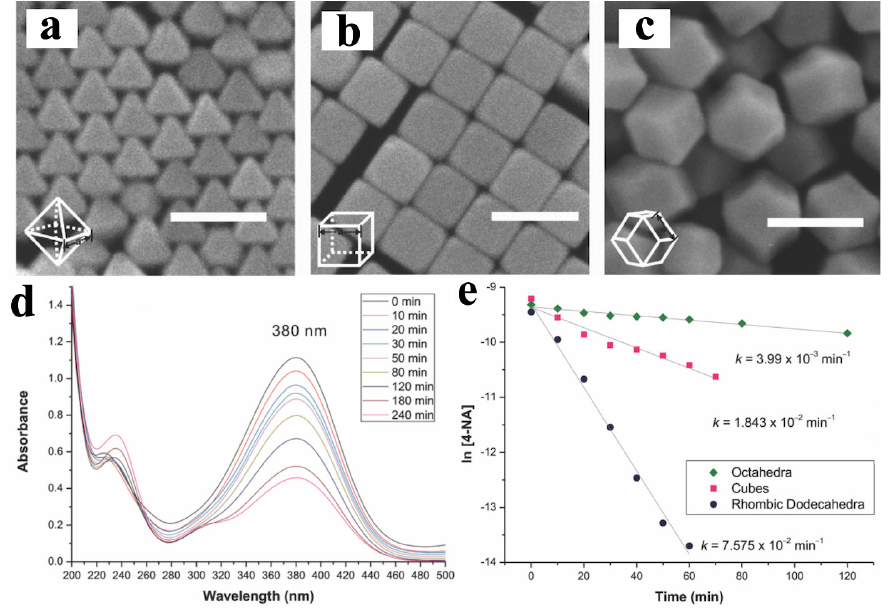
Figure 13 - SEM images of a) Au octahedra, b) Au nanocubes, and c) Au rhombic dodecahedra. Scale bars are equal to 100 nm. d) Time-dependent UV-vis absorption spectra for the borohydride reduction of 4-aminophenol (4-NA) at 25 °C and e) ln(4-NA) versus time plots using gold nanocubes, octahedra, and rhombic dodecahedra as catalysts (green, red and black points, respectively). Adapted with permission from ref. (Chiu et al. 2012) Copyright 2012 American Chemical